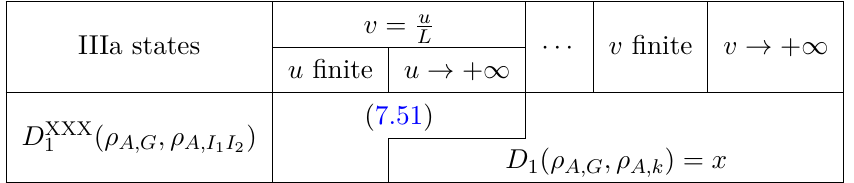
Table 1 . The subsystem trace distance between the ground state and the case IIIa double-magnon bound states in XXX